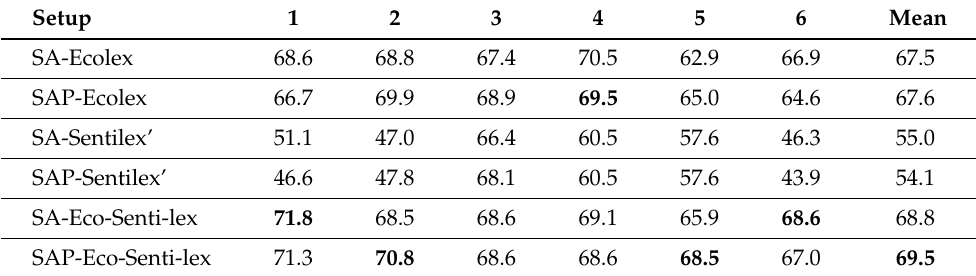
Table 10. Weighted F1-score results on sentence